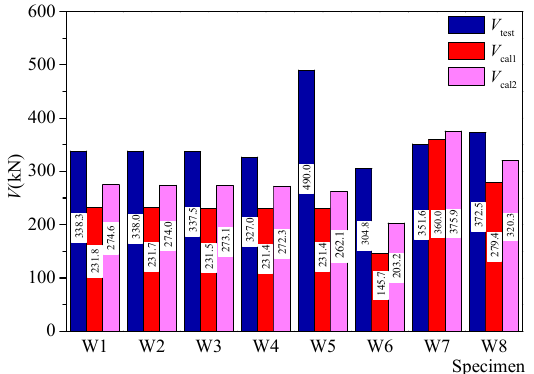
Figure 18. Experimental and calculated shear strengths.